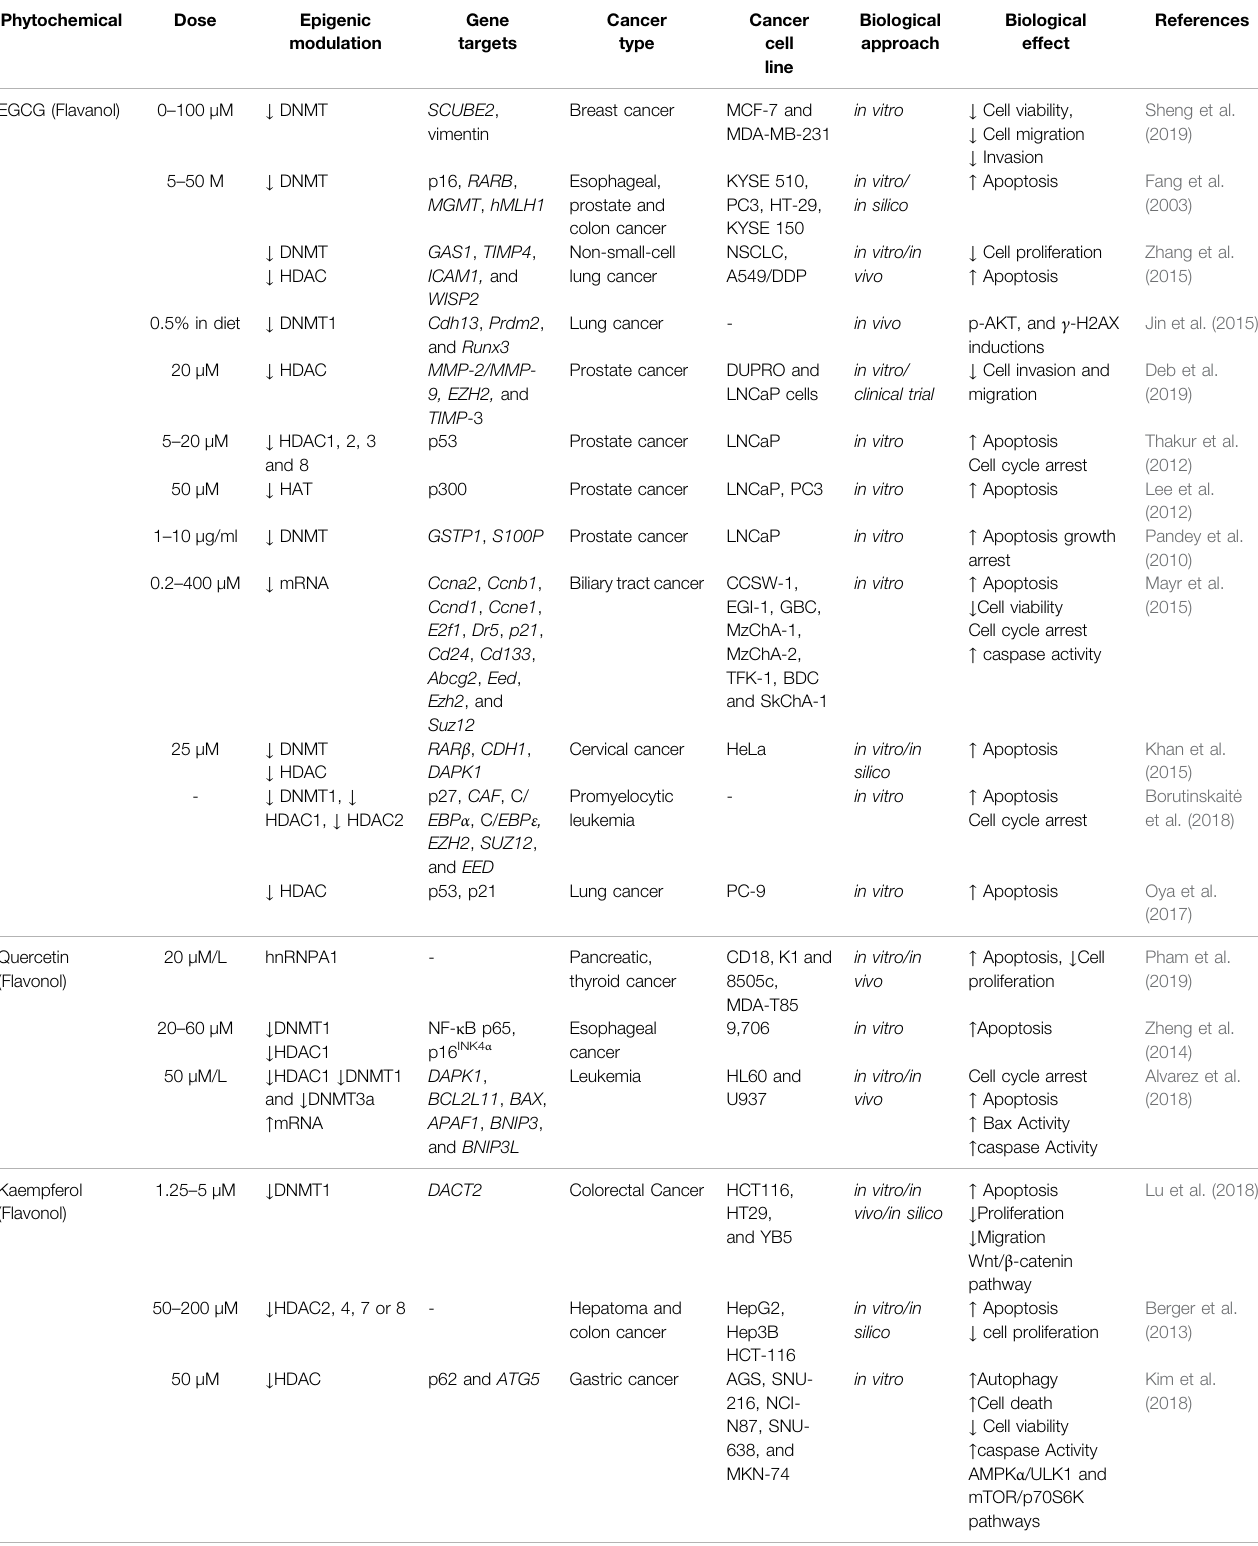
TABLE 1 | Epigenetic modulations by some potent fl avonoids ( ↑ increase, ↓